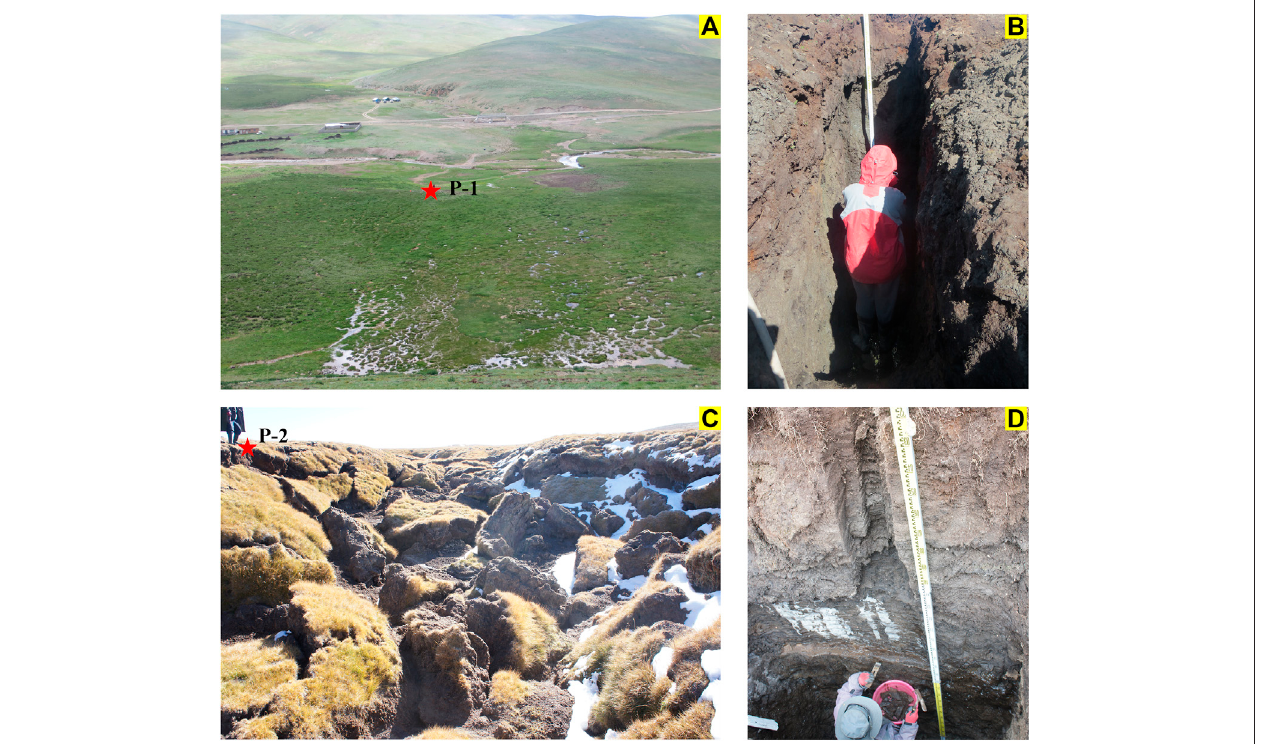
FIGURE 2 | Landscapes for the two permafrost pro fi les (A,B) and sampling pictures (C,D) .